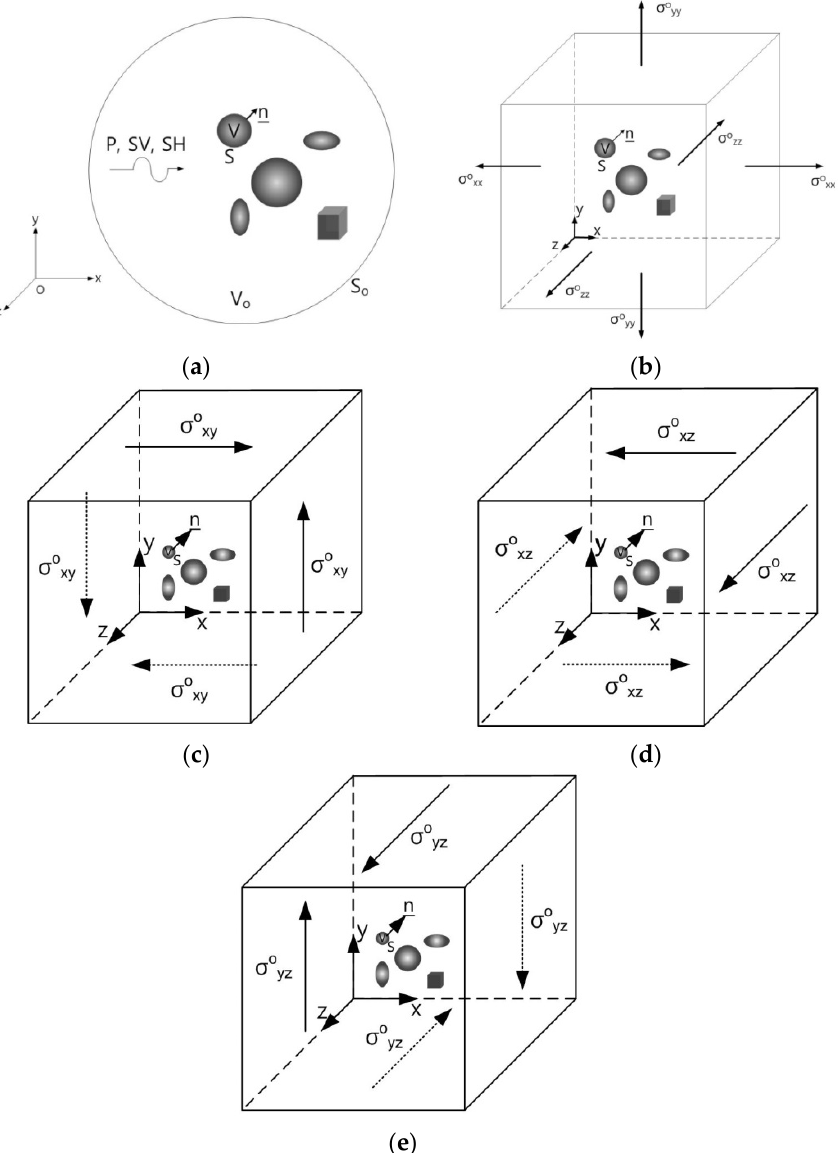
Figure 1. Geometry of the general ( a ) elastodynamic and ( b ) elastostatic problem. ( c ) A remote shear loading, σ oxy . ( d ) A remote shear loading, σ oxz . ( e ) A remote shear loading, σ oyz .